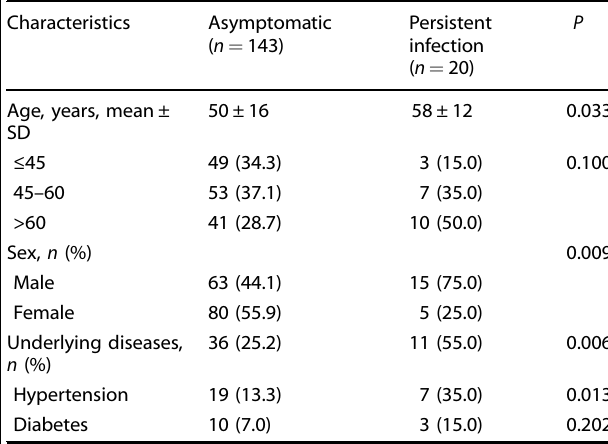
Table 1. Basic information of the asymptomatic patients with